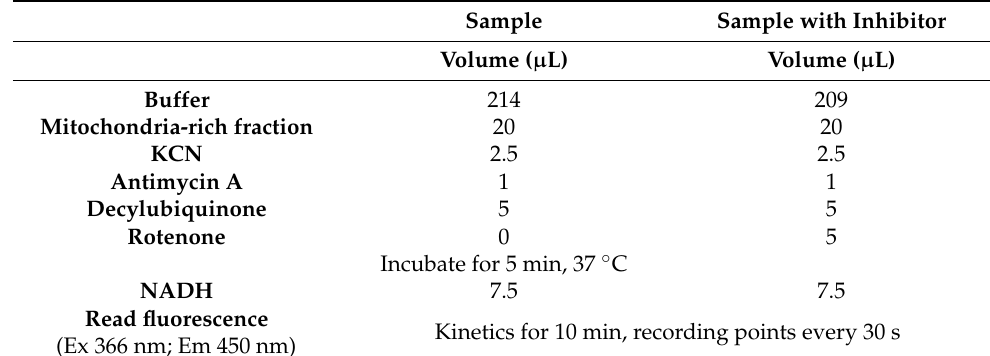
Table 5. Conditions and flow setup for Complex I activity assay.